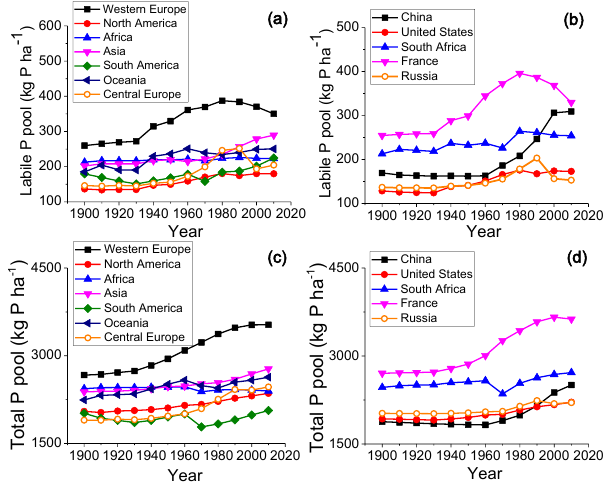
Figure 7. Changes of soil LP (a) in different world regions and (b) in different countries, and TP pools (c) for different world re- gions and (d) countries in arable land for the period